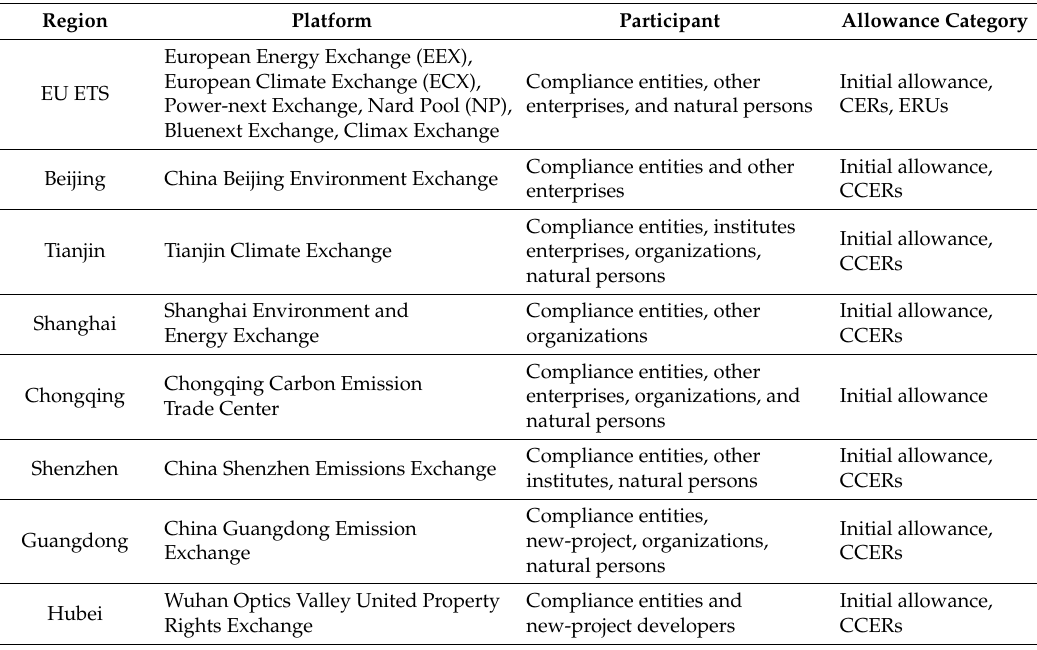
Table 7. Trading participants and allowance categories in EU ETS and China’s pilot ETS. Region